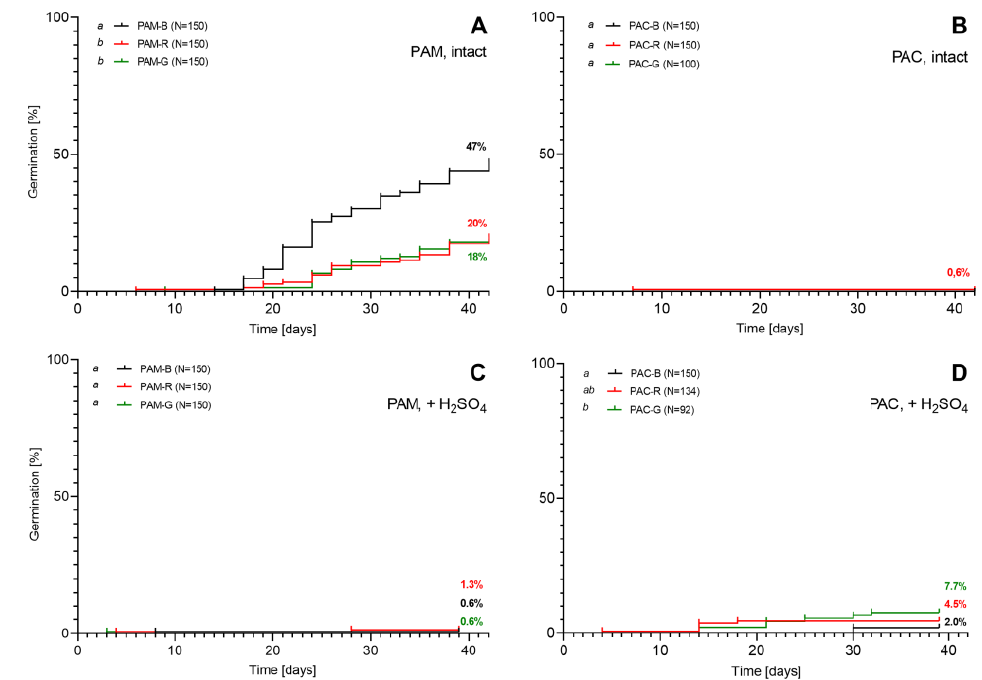
Figure 1. The germination of fresh seeds of Phytolacca americana (PAM; graphs ( A , C )) and P. acinosa (PAC; graphs ( B , D )) in Petri dishes immediately after the extraction from fresh fruits of different ripeness: immature (green (G) and red (R)) and ripe (black) (B). Graphs ( A , B ) show the germination of sterilised seeds without pre-treatment (experiment 1). Graphs ( C , D ) show the germination of fresh seeds after treatment with 95% sulfuric acid (experiment 2). A log-rank (Mantel–Cox) test was used for the comparison of the survival curves. Letters a and b in legends mark statistically different curves.